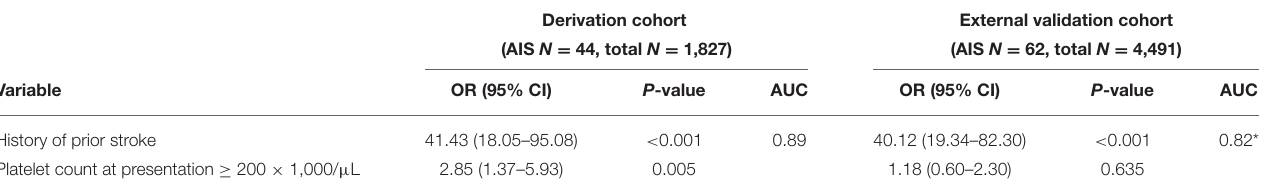
TABLE 3 | Predictors of acute ischemic stroke vs. no ischemic stroke in the derivation and validation